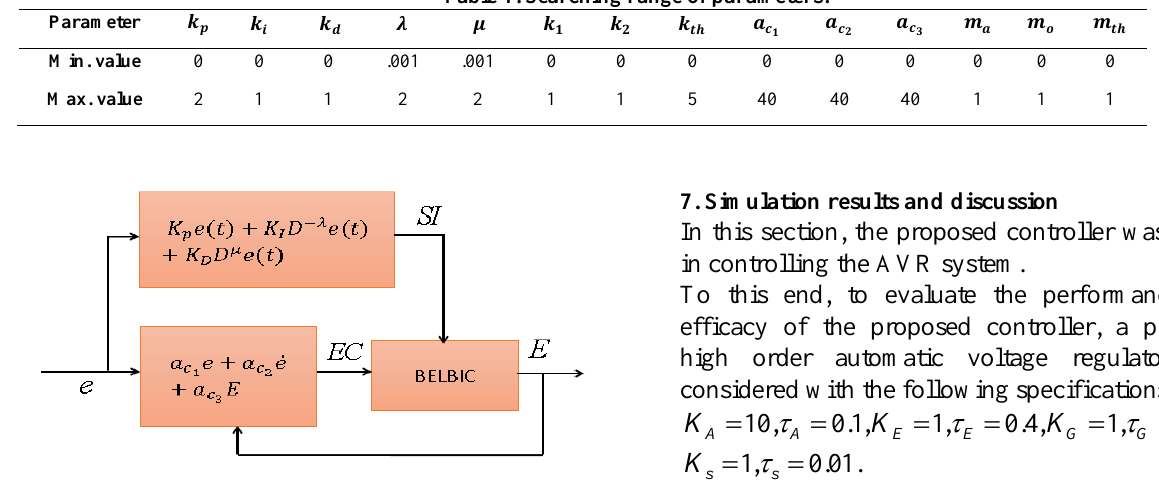
Figure 7. Block diagram of the proposed